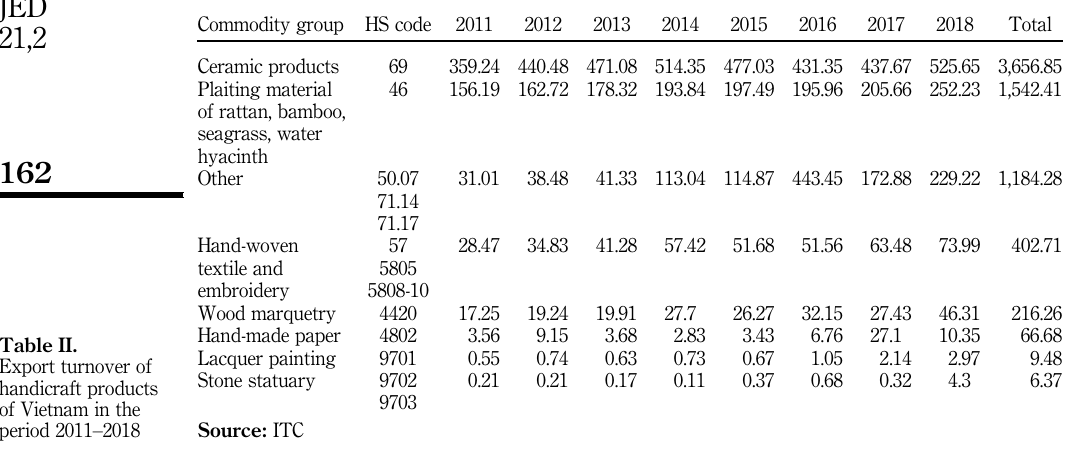
Table II. Export turnover of handicraft products of Vietnam in the